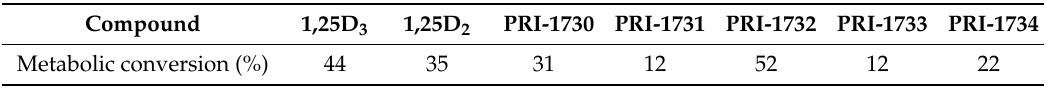
Table 2. Metabolic conversion of active forms of vitamin D and its analogues by human CYP24A1 (%). Compound 1,25D 3 1,25D 2